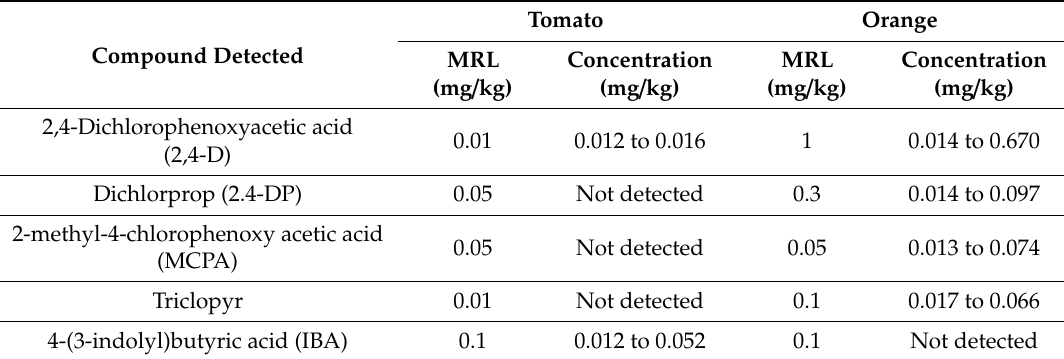
Table 4. Compounds in analyzed samples above the LOQ of the method expressed as mg /